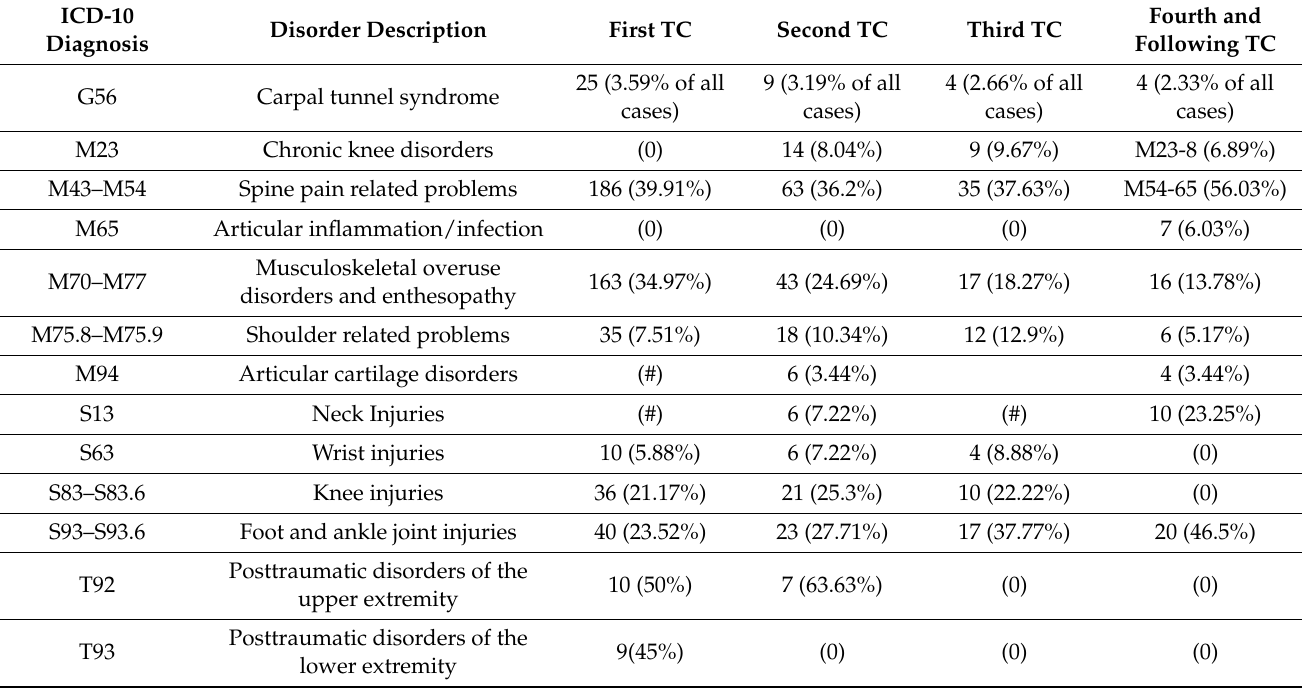
Table 4. Percentage of cases with specific diagnoses during consecutive